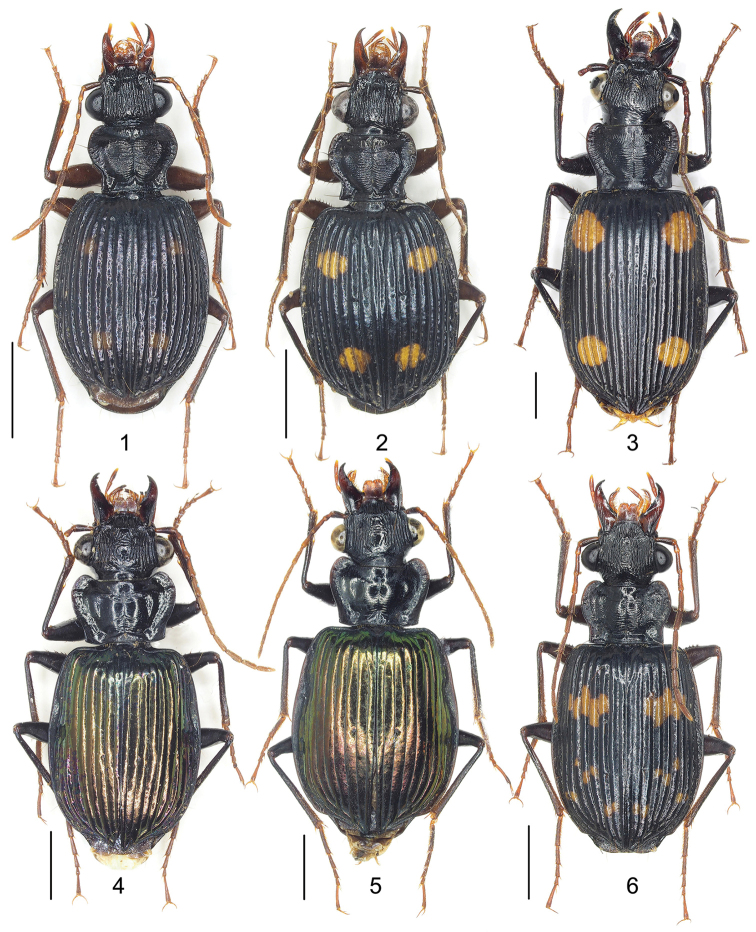
Habitus 1
P.
gibbosus sp. n., holotype, Myanmar (Putao), male 2
P.
gibbosus sp. n., paratype, Myanmar (Putao), female 3
P.
dux Andrewes, Yunnan (Jinghong), female 4
P.
elegans sp. n., holotype, Xizang (Mêdog), male 5
P.
elegans sp. n. paratype, Xizang (Zayü), female 6
P.
amplus Andrewes, Myanmar (Putao), male. Scale bars: 2 mm.